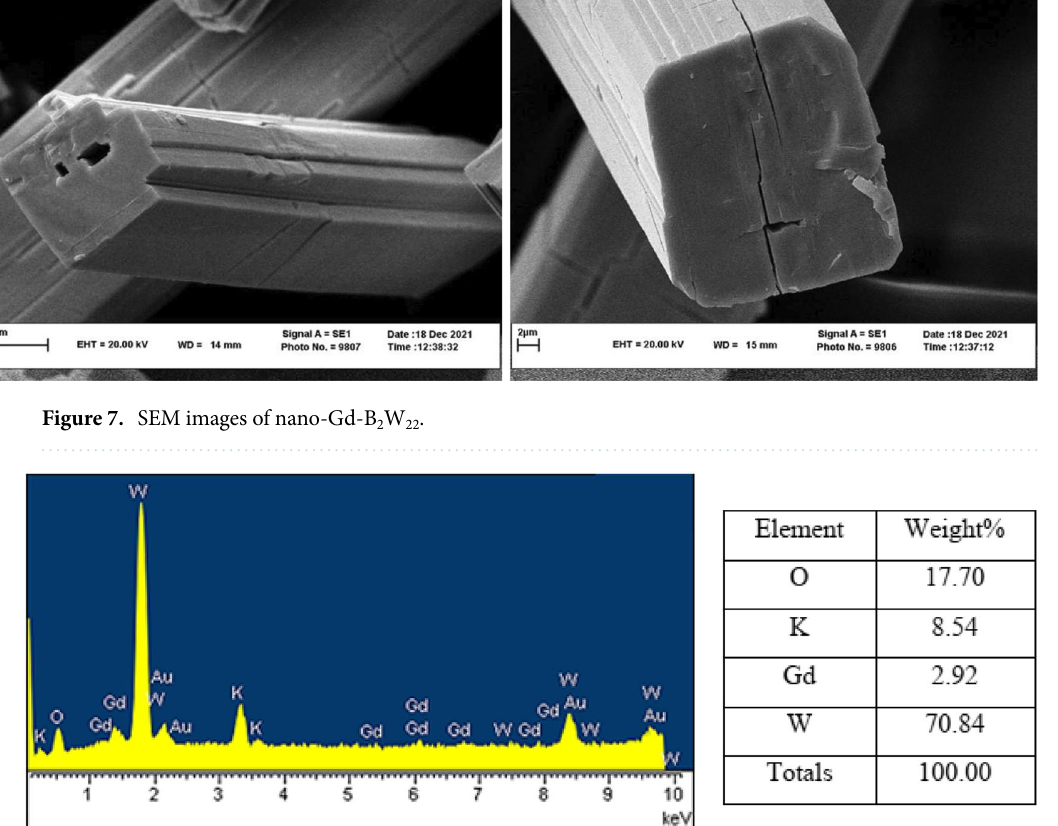
Figure 8. EDS spectrum of nano-Gd-B 2 W 22